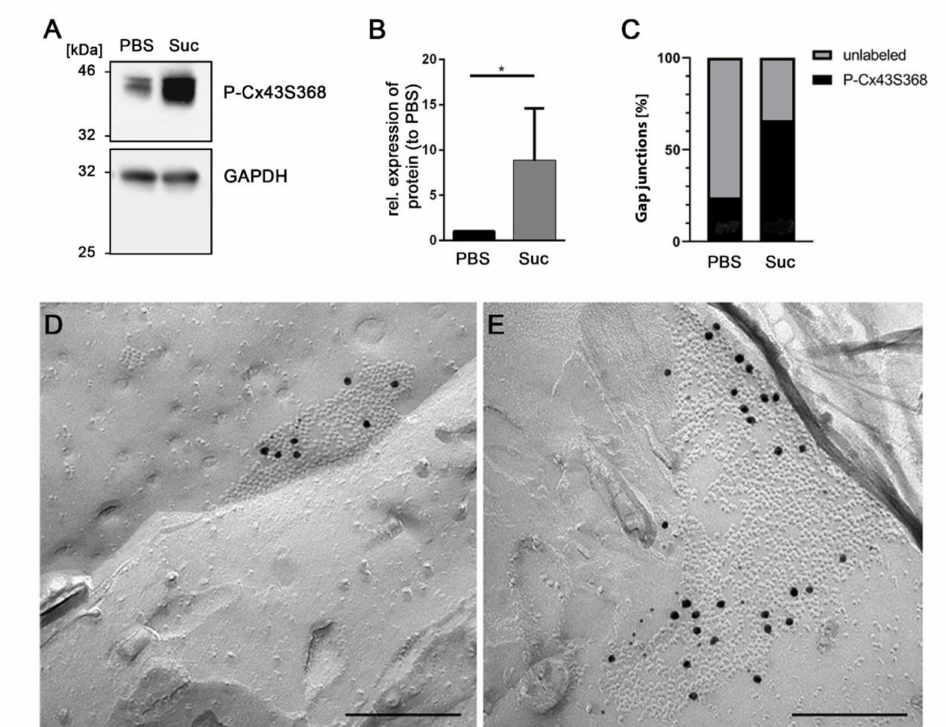
Figure 4. Sucrose-treatment results in phosphorylation of Cx43 at Serine 368. Antibodies rec- ognizing the phosphorylation of S368 were used for Cx43-immunolabeling in sucrose-treated (hyperosmolar condition) or PBS-incubated (control condition) astrocytes in immunoblots and FRIL analysis. ( A ) The immunosignal of the Cx43S368 phosphorylated isoform was enhanced in sucrose-treated astrocytes (Suc) as compared to control astrocytes (PBS). GAPDH served as a loading control. Original images are shown in Supplementary File S1. ( B ) Quantification of n = 4 experiments confirmed a significant difference: * p < 0.05. Shown are signal intensities relative to the control (PBS), illustrated as mean + SEM. ( C ) Freeze-fractured replicas of control cells (PBS) or sucrose-stimulated cells (Sucrose) were labeled with antibodies recognizing the phosphorylation of S368. In replicas of n = 2 experiments, the number of gap junctions display- ing phosphorylated Cx43S368-immunolabeling was determined. In comparison, 27 phospho (P)- Cx43S368-immunopositive gap junctions (black) and only 14 unlabeled gap junctions (gray) were found in membranes of sucrose-treated cells, whereas in membranes of control cells, only 7 gap junctions were P-Cx43S368-immunopositive (black) and 22 were found to be unlabeled (gray). ( D , E ) Examples of phospho-Cx43S368 immunolabeled gap junctions. Small and large black dots represent 6 nm and 18 nm colloidal gold, respectively, coupled to secondary antibodies. Although only one quarter of gap junctions of control astrocytes (PBS) displayed phosphorylated Cx43S368 labeled gap junctions, an image of one of these labeled gap junctions is shown ( D ). In contrast, 66% of gap junctions in sucrose-treated cells contained Cx43 phosphorylated at S368 ( E ). Scale bars represent 100